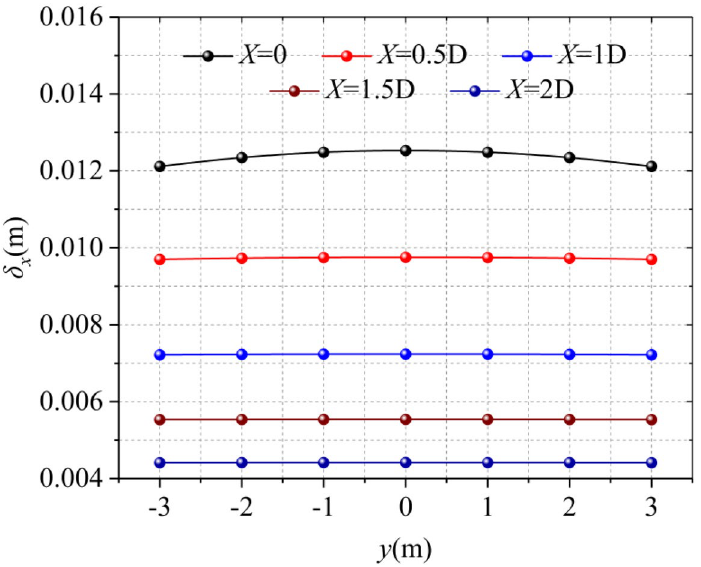
Figure 14. Horizontal displacement at different distances from the trench (H = 0 m).